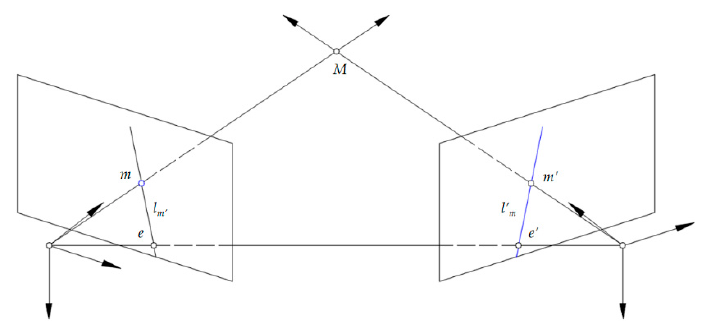
Figure 6. Illustration of the fundamental matrix constraint.